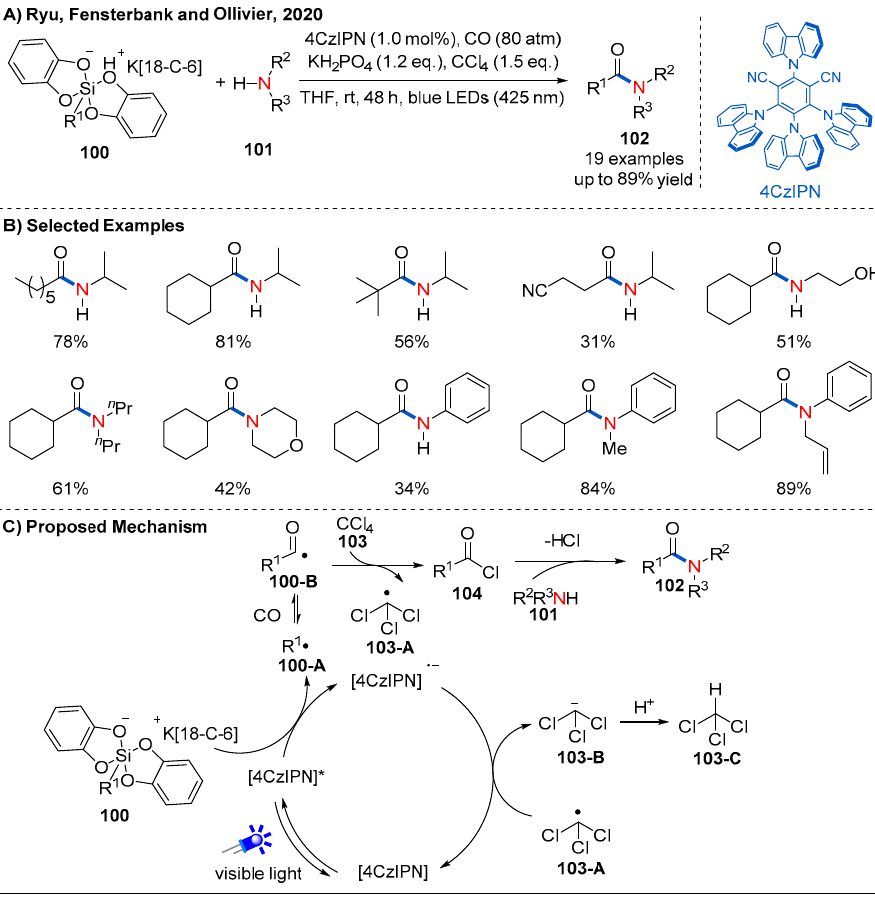
Figure 31. Visible-light-driven photoredox-catalyzed oxidative aminocarbonylation of alkyl silicates.